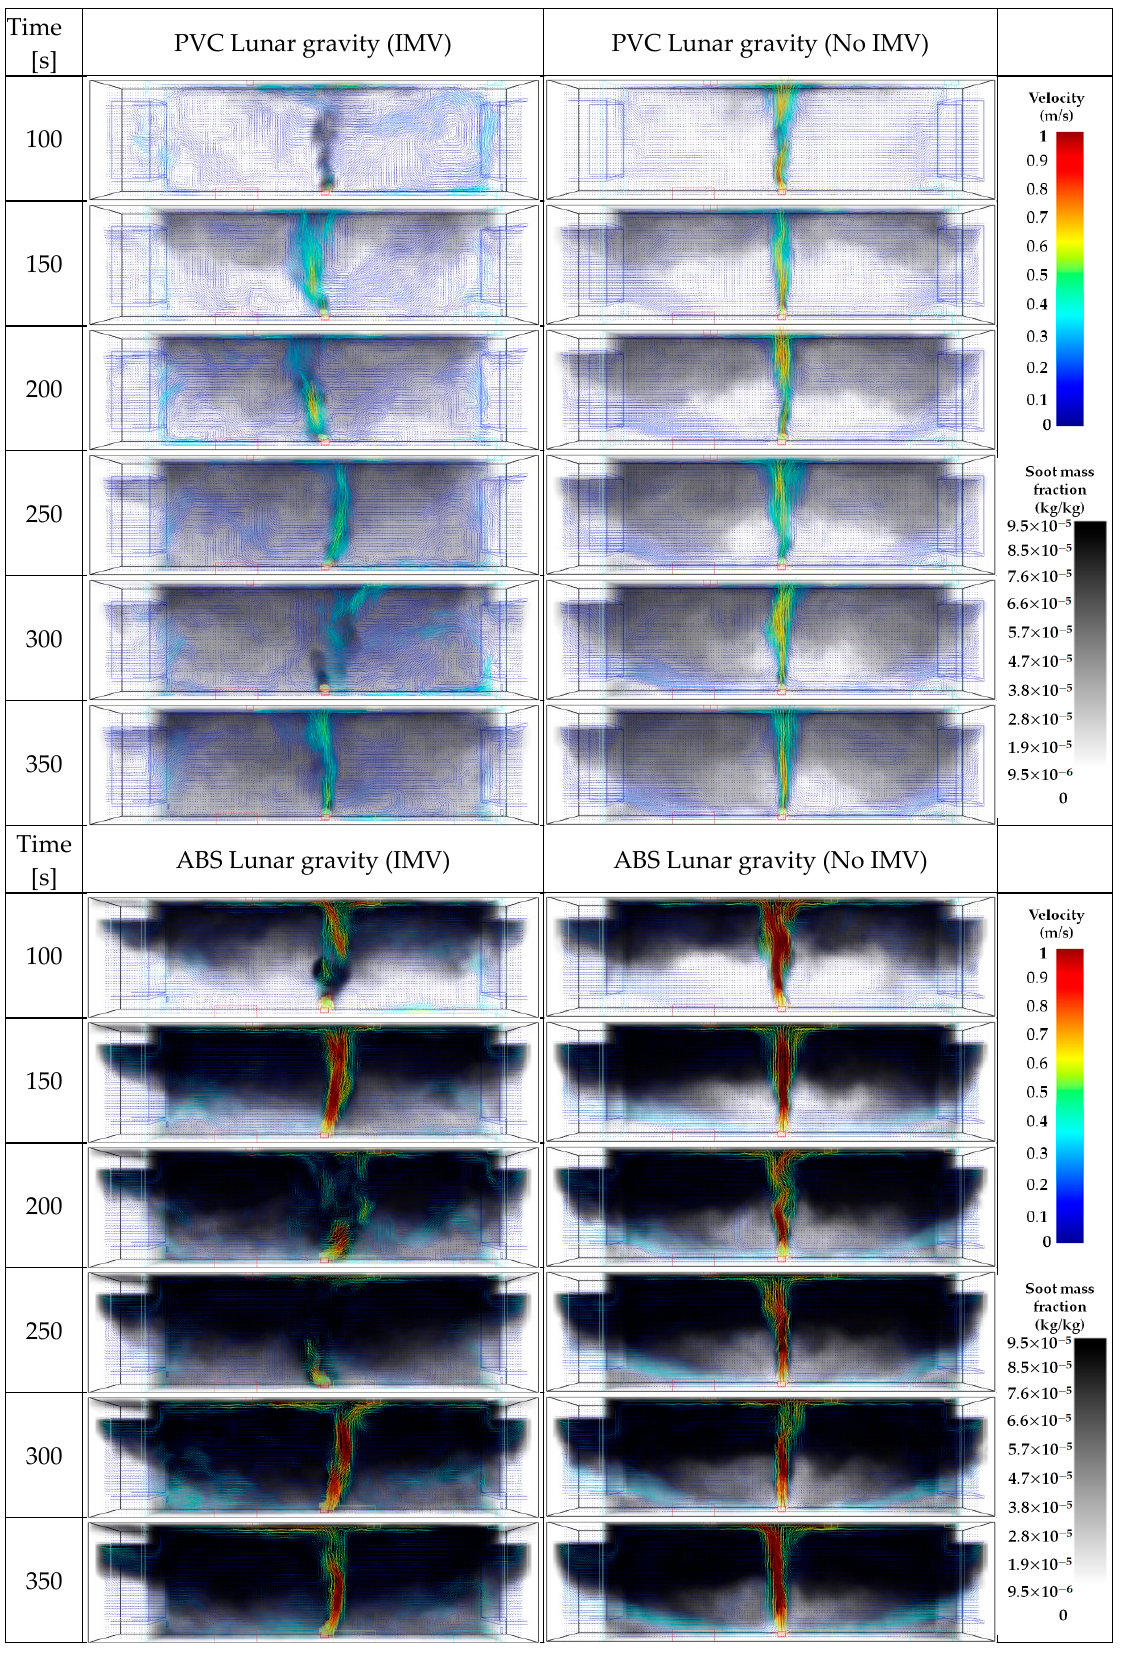
Figure 7. Smoke mass fraction with respect to time of PVC and ABS with and without IMV under lunar gravity.